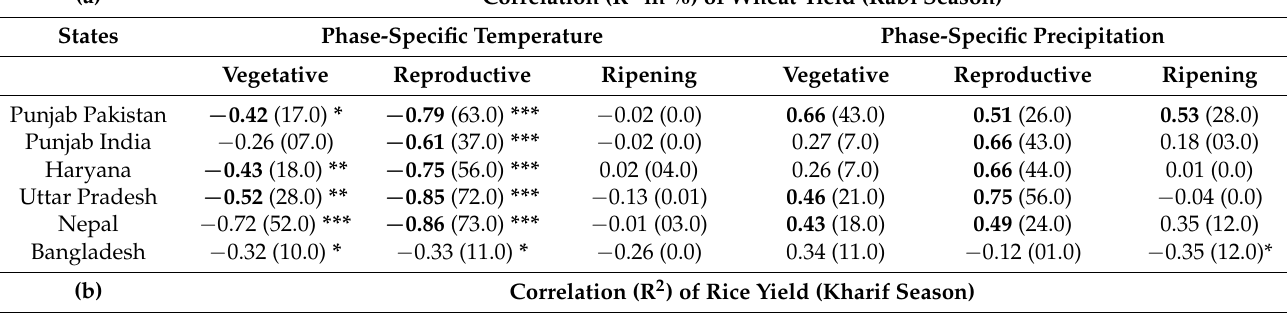
Table 6. Time series Correlation and Coefficient of Determination (R 2 in %) of simulated wheat ( a ) and rice ( b ) crop yields with crop phase-specific temperatures and precipitation over six study sites in the IGB river basins during the period 1981–2010. Bold numbers show the strong correlation, i.e., more than 0.40 between wheat and rice crop yields with crop phase-specific climate variables and star shows the statistically significance